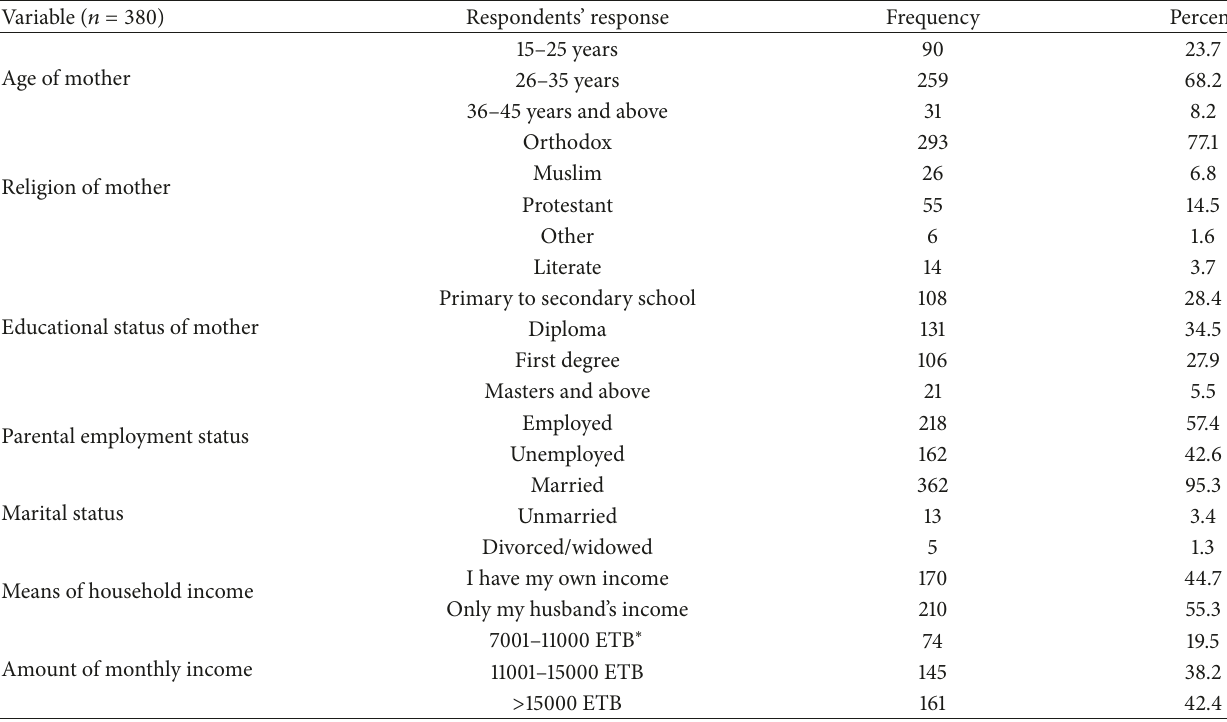
Table 1: Sociodemographic characteristics of mothers attending private pediatric and child clinics, Addis Ababa, Ethiopia, March–May 2016.